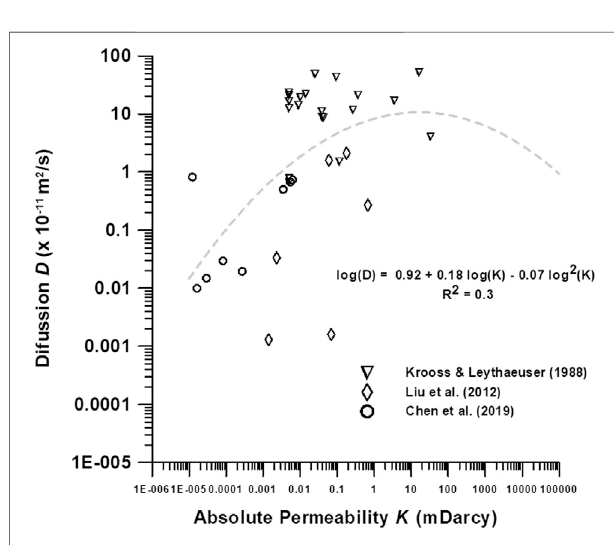
FIGURE 5 | Scatter log-log plot of diffusion coef fi cient for methane (x 10 − 11 m 2 /s) in different rock samples (i.e., claystone/limestones, shales, mudstones, siltstones, and medium/ fi ne-grained sandstones) versus absolute permeability values (after Krooss and Leythaeuser, 1988; Liu et al., 2012; Chen et al., 2018). The best approximation to the trend displayed by these data is the sketched quadratic function (dotted-line) used to assign empirical D values to each permeability range for the lithologies